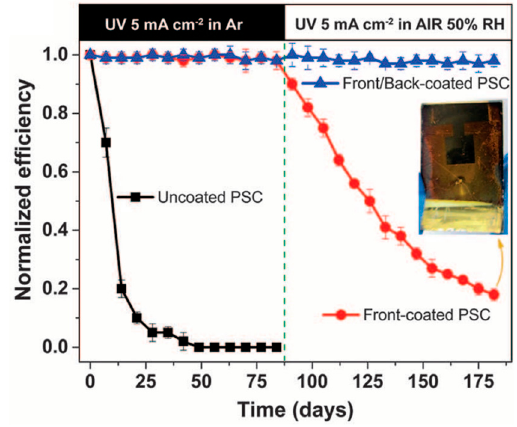
Figure 4. The aging test results on the three series of PSCs: (i) uncoated, (ii) front-coated with a luminescent fluorinated coating, and (iii) front/back-coated (front coating with the luminescent fluorophore and back contact coating with a moisture resistant fluoro-polymeric layer). The cells were stored in an Ar environment during the first three months of the test period. They were kept in the air with RH = 50% for the next three months. During the whole testing period, the PSCs were exposed to continuous UV illumination. The device power conversion efficiency (PCE) was recorded once a week. The inset shows a photograph of a front-coated solar cell at the end of the test. Reprinted with permission from [77]. Copyright 2018 American Association for the Advancement of Science.